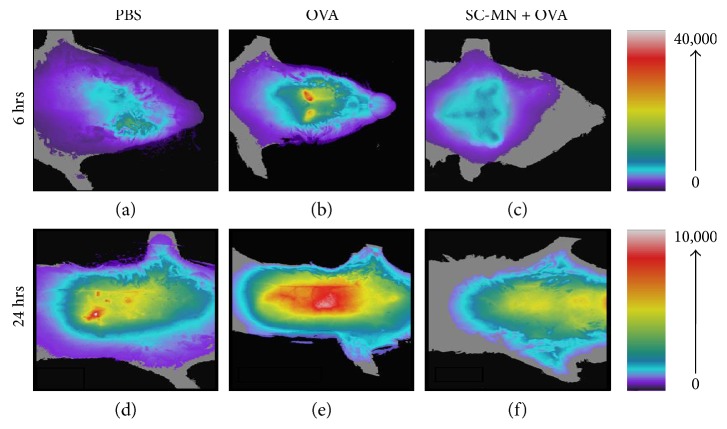
Homing of cyclic RGD-liposomes to cervical lymph nodes and lungs in allergic asthmatic mice. Cyclic RGD- and DiR-labeled liposomes were injected intravenously into OVA-allergic BALB/c mice. (a, d) PBS-challenged; (b, e) OVA-challenged; (c, f) mannan pretreatment (1 mg, i.n., 30 min before each of the three OVA challenges). FRI images were acquired 2, 6, and 24 hr postinjection. The intensity of the signals in the cervical lymph nodes (c) and lungs (f) in SC-MN-pretreated mouse was markedly diminished compared to that in the OVA-challenged mouse (b, e). Signals in the lungs were detected at the 24 hr time point (d–f). The results are representative of 2 separate experiments with similar results.